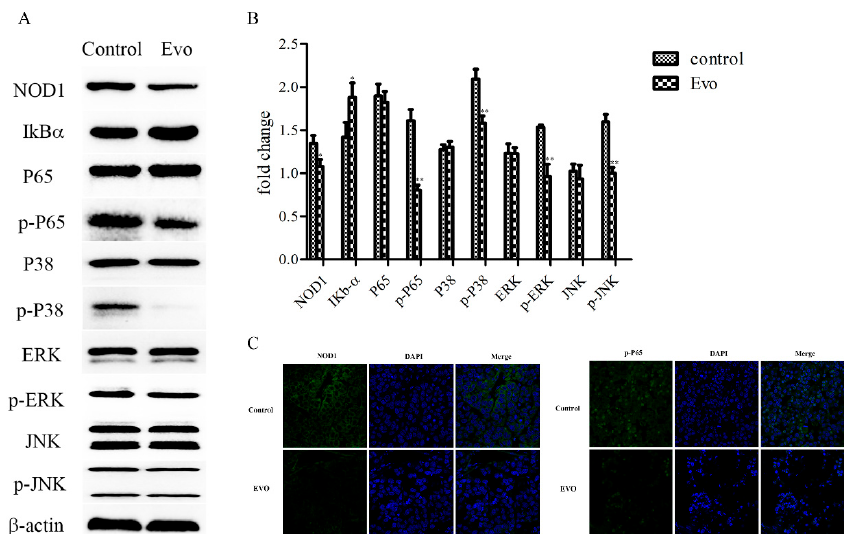
Figure 5. Evo-induced apoptosis of HCC cells occurred via the NOD1 pathway in vivo. ( A , B ) The mice treated with or without 10 mg/kg of Evo. Levels of proteins in the NOD1 pathway in tumor tissues were detected by the Western blot method. ( C ) Representative images from the immunofluorescence method. Expression of NOD1 ( × 400) and p-P65 ( × 200) in tumor tissues was analyzed by the immunofluorescence method. Values are means and standard errors of five separate experiments (* p < 0.05 and ** p < 0.01 versus control).